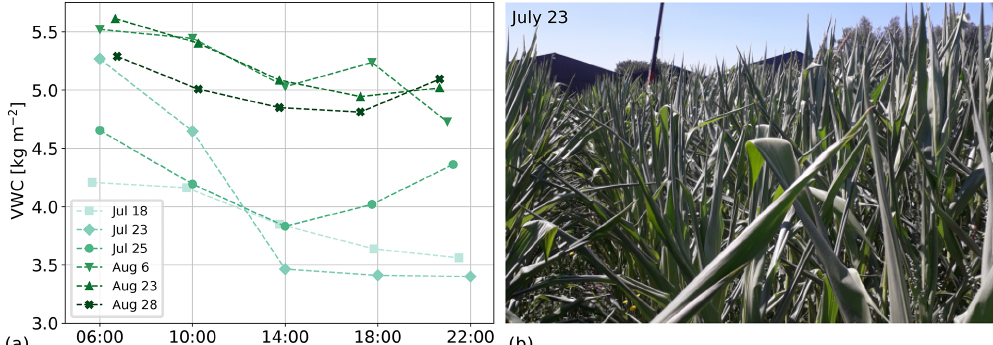
Figure 3. Sampled vegetation water content (VWC) in the mid-season, 2019 (a) , and a picture of rolled leaves (b) , taken around the third measurement on 23 July, as a sign of drought